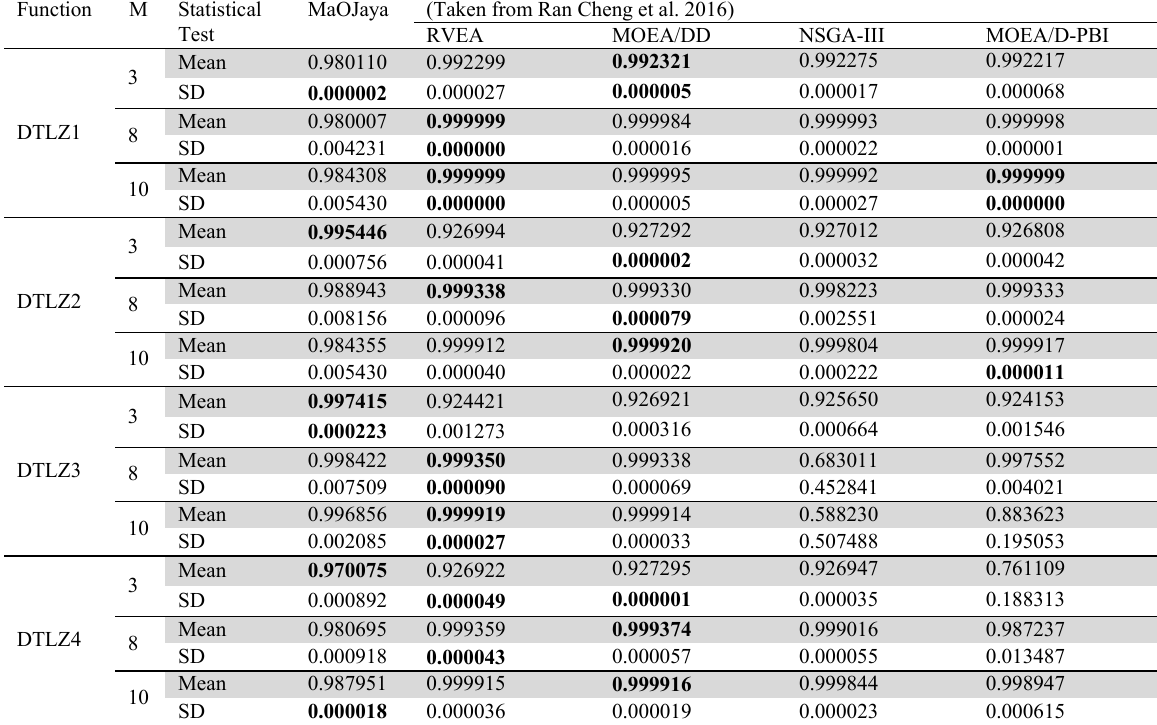
HV values of DTLZ1 – DTLZ4